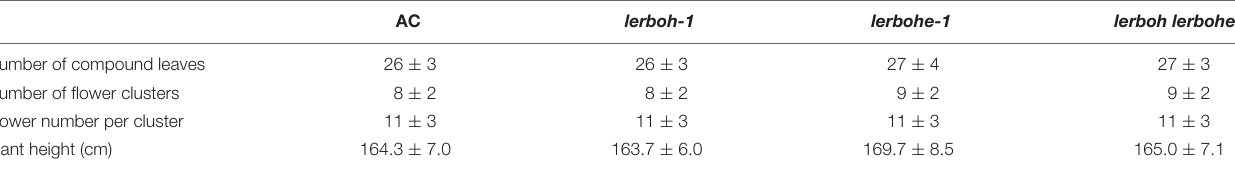
FIGURE 2 | Developmental phenotypic analysis of lerboh/lerbohe mutants. (A–D) Growth phenotype of WT (AC) (A) , lerboh-1 (B) , lerbohe-1 (C) , and lerboh lerbohe-1 (D) plants. The cross fruits fertilized by AC pollens in lerbohe-1 or lerboh lerbohe-1 lines are boxed and shown enlarged in the inset. (E–G) Phenotypic analysis of flowers (E) , stamens (F) , and Pistils (G) for (from left to right) WT (AC), lerboh-1 , lerbohe-1 , and lerboh lerbohe-1. (H,I) Fruit phenotype of (from left to right) AC, lerboh-1 (self-fertilized) and lerbohe-1 , lerboh lerbohe-1 (fertilized by AC pollens). (J) Number of seeds in a fruit of AC (self-fertilized) and lerbohe-1 , lerboh lerbohe-1 (fertilized by AC pollens). (K) Germination ratio of F 1 seeds. Scale bar: plants, 10 cm; flowers, 1 cm; flower organs, 3 mm; fruits, 2 cm. TABLE 1 | Growth phenotypic analysis of lerboh/lerbohe mutants. lerboh-1